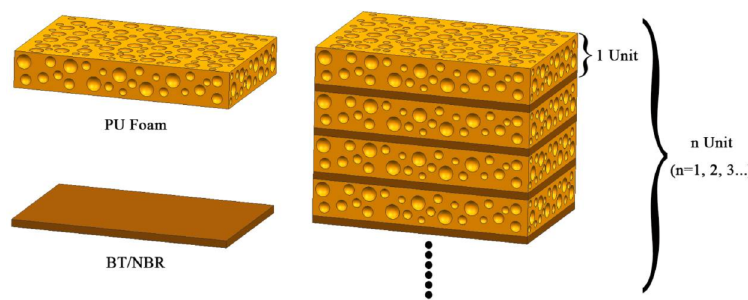
Figure 1. Schematic of BT/NBR-PU foam composite.